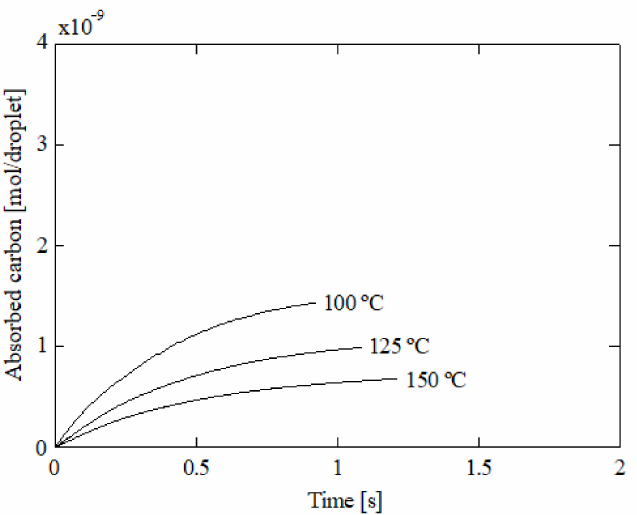
Figure 14. Absorbed carbon by a droplet for several initial gas temperatures; 5% initial ammonia concentration, 5 ◦ C initial liquid temperature, and 1000 µ m initial diameter.